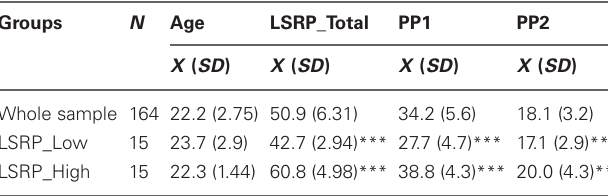
Table 1 | Mean age and scores on self-reports of